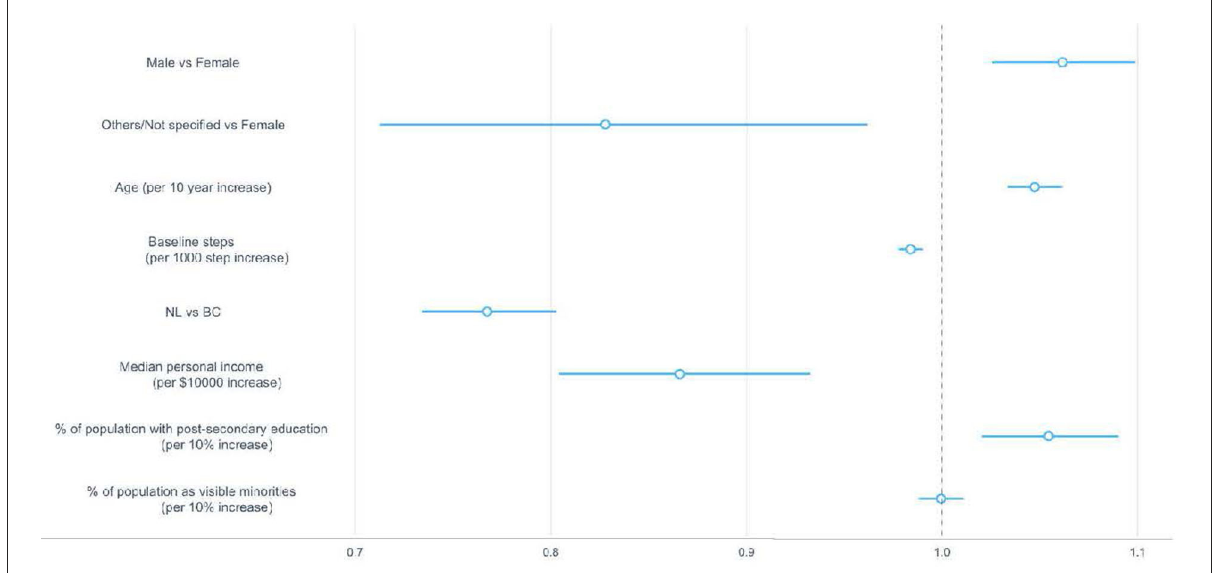
FIGURE7 Hazard ratios and 95% confidence intervals for sociodemographic correlates associated with the likelihood of resuming the second streak. The dotted vertical line indicates a hazard ratio of 1, which means the presence of a correlate neither increased nor decreased the likelihood of resuming the second streak. BC, British Columbia; NL, Newfoundland and